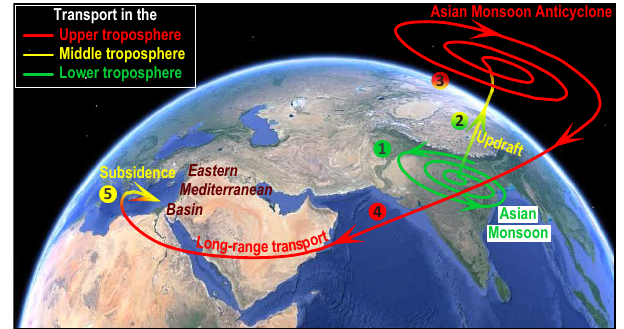
Figure 12. Schematic representation of the processes impacting the mid-to-upper tropospheric pollutants, including CH 4 , above the EMB in summer (July–August). (1) Trapping of lower tropospheric pollutants in the Asian monsoon. (2) Updraft of pollutants in the Asian monsoon up to the upper troposphere. (3) Build-up of pollu- tants within the Asian monsoon in the upper troposphere. (4) Large- scale redistribution of pollutants by the Asian Monsoon Anticy- clone to the Middle East and North Africa in the upper troposphere. (5) Build-up of pollutants though descent down to the middle tro- posphere above the